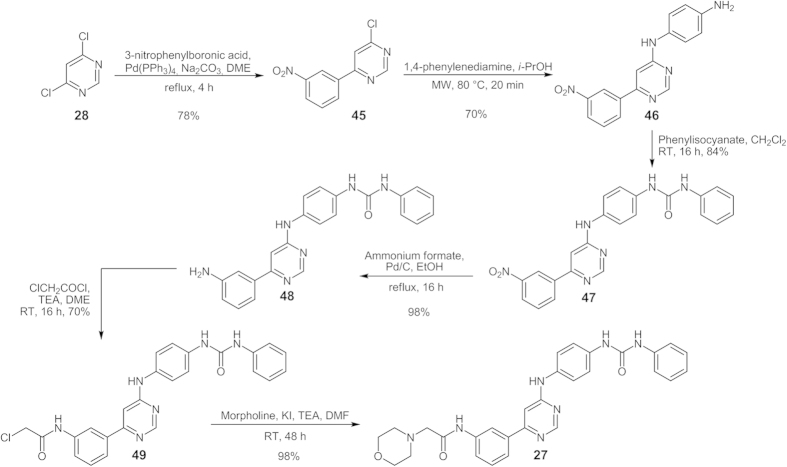
Synthesis of compound 27.